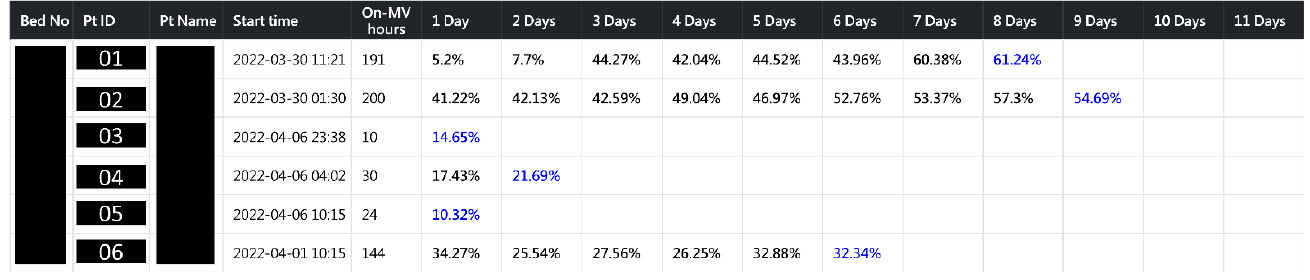
Figure 3. A screenshot of the AI prediction system (digital dashboard).